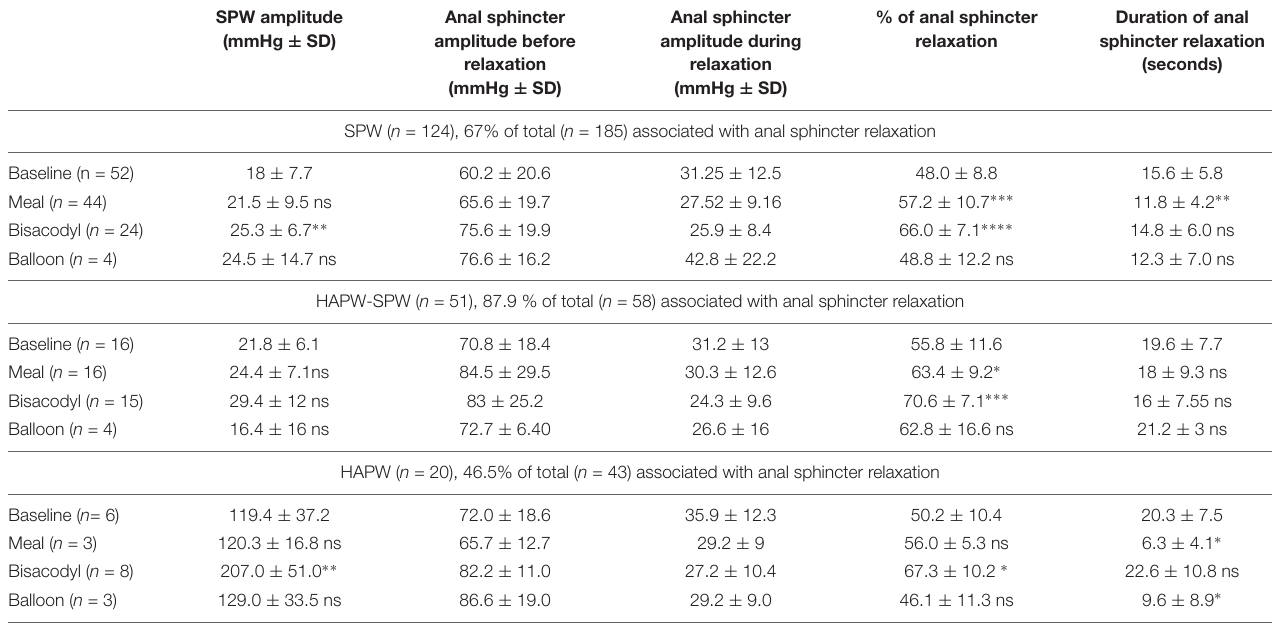
TABLE 2 | Anal sphincter relaxation associated with SPWs, HAPW-SPWs and HAPWs.